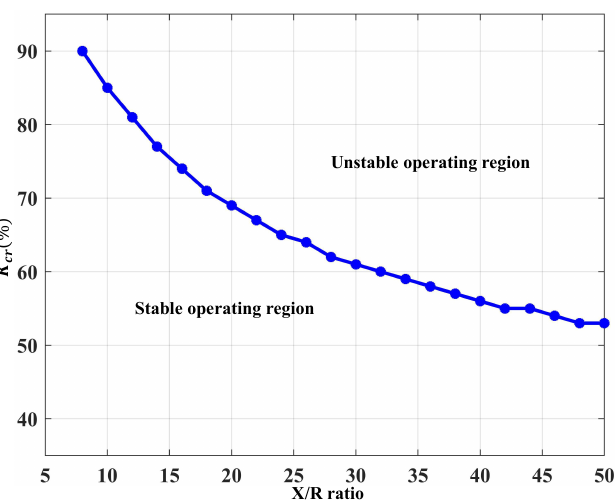
Figure 9. Stability boundary of the system using SVC with respect to the X / R ratio of network.